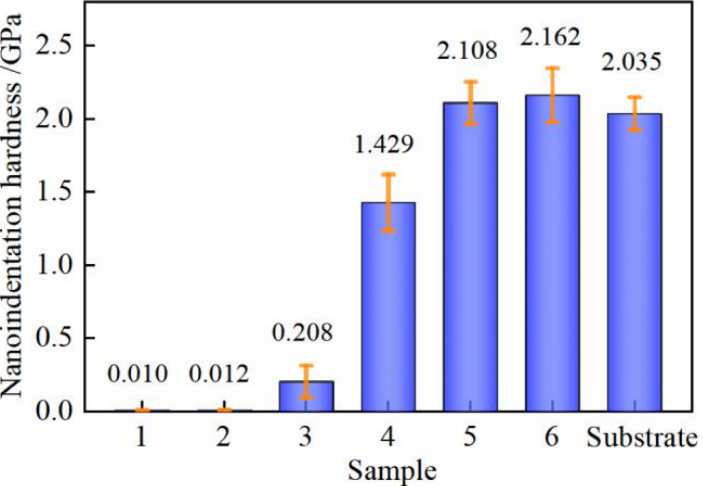
Figure 8. Comparison of the nanoindentation hardness of the laser-cleaned samples and substrate.